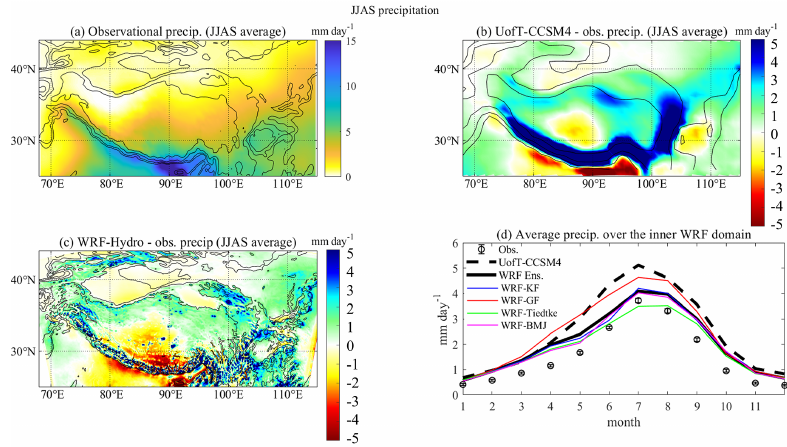
Figure A1. JJAS precipitation bias with respect to (a) the CRU observational dataset for (b) UofT-CCSM4 and (c) the WRF ensemble. (c) Monthly precipitation over the inner WRF domain in the observation, UofT-CCSM4, WRF ensemble average, and four individual physics ensemble members. The topography contours of 500, 1000, 2000, and 4000m are also shown in black in (a) – (c) .